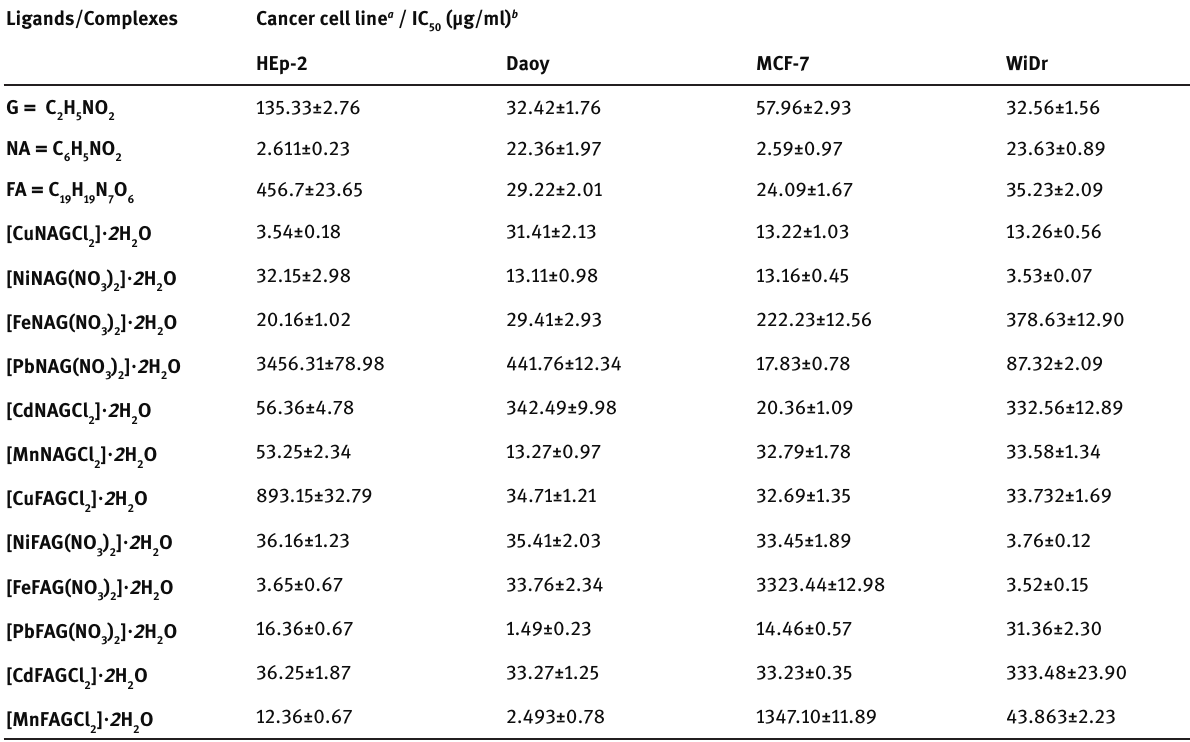
Table 5: Cytotoxicities of mixed glycine (G) – vitamin (NA/FA) – metal drug complexes.